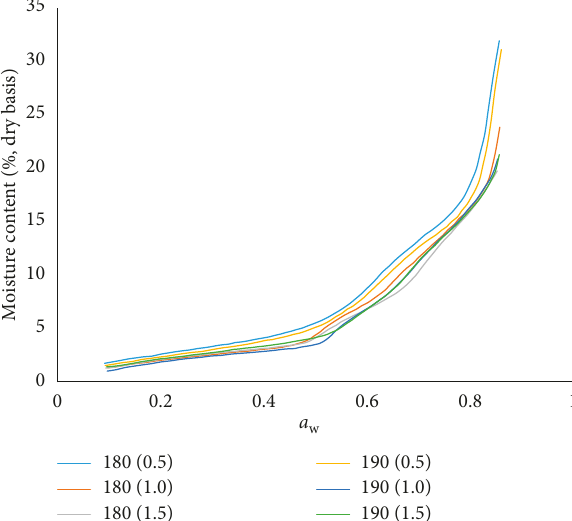
Figure 4: DDI comparative sorption isotherms of the MD powders at different drying temperatures.